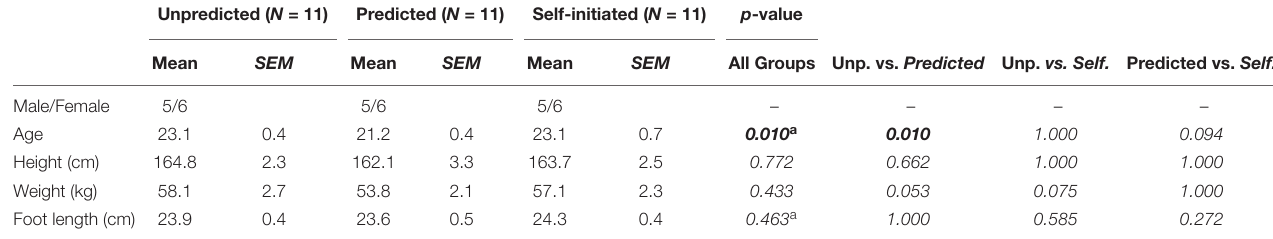
TABLE 1 | Demographic data.